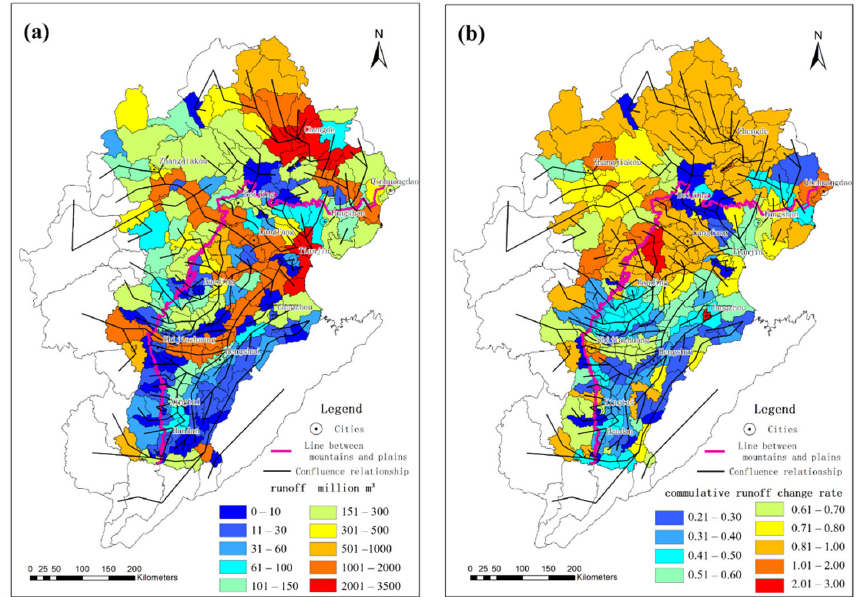
Figure 11. Mutual feedback relationships among units in the Beijing–Tianjin–Hebei region for ( a ) actual runoff and ( b ) cumulative runoff change rate.